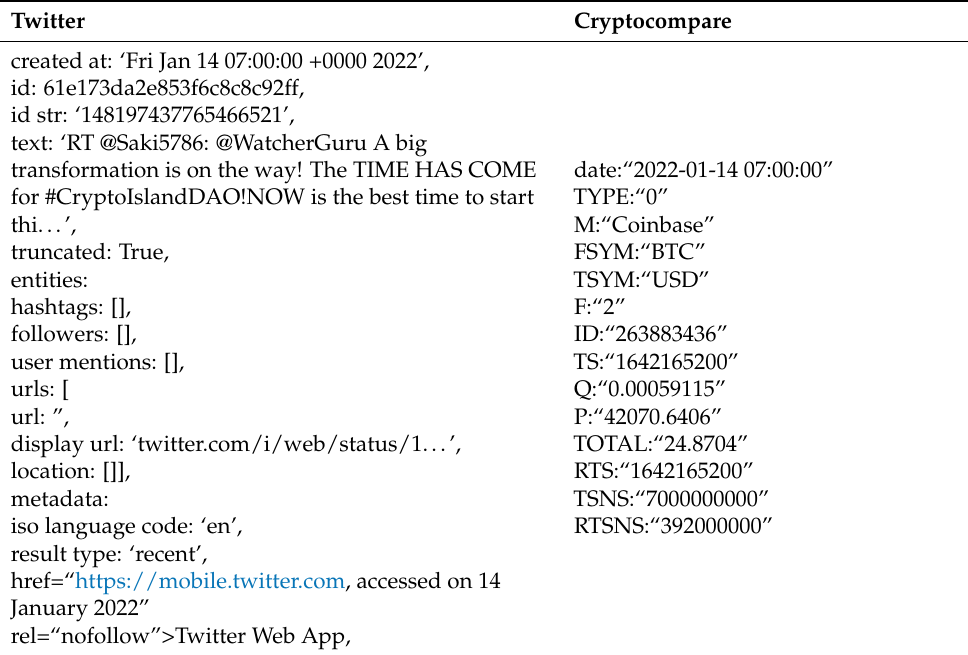
Table 1. Attributes of each raw dataset